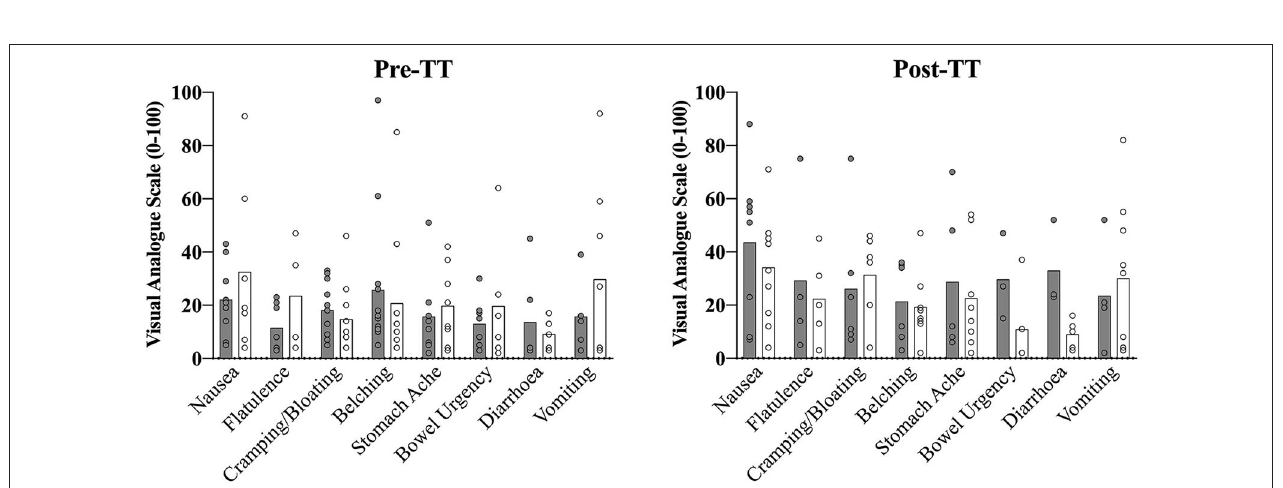
FIGURE 5 | Summed descriptive (individual and mean ± SD) symptom data collated from the GI questionnaire (0–100 point visual analog scale) prior to the start of the 2,000-m TT (Pre-TT) and upon completion (Post-TT) for both the consensus standard (CON; gray bar) and individualized peak (IP; open black border)